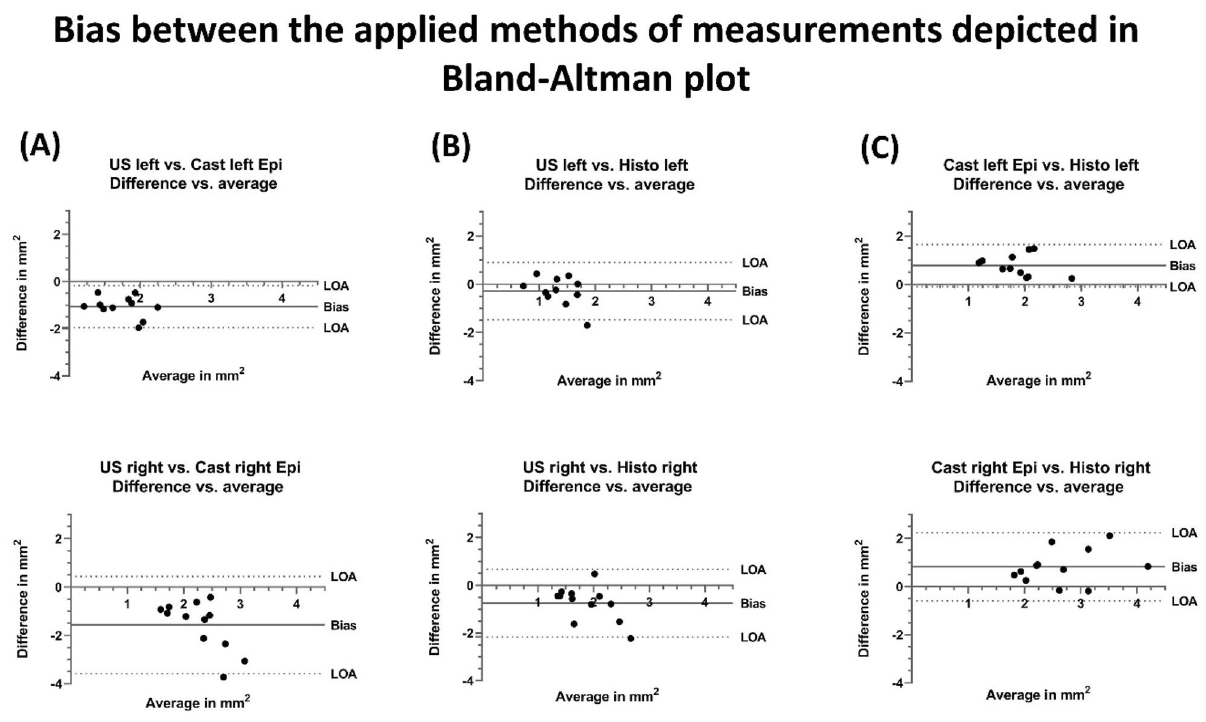
Figure 5. Bland–Altman plots showing the differences of measurement between the applied methods for cross- sectional area detection. Most values lied within the 95% confidence interval (LOA) yielding that differences are distributed within close borders. Ultrasound (US) and casting (Cast) with epineurium (Epi) showed negative bias ( A ), ultrasound versus histology (Histo) likewise a negative bias ( B ), and casting with epineurium versus histology a positive bias for both body sides ( C ). LOA Limits of